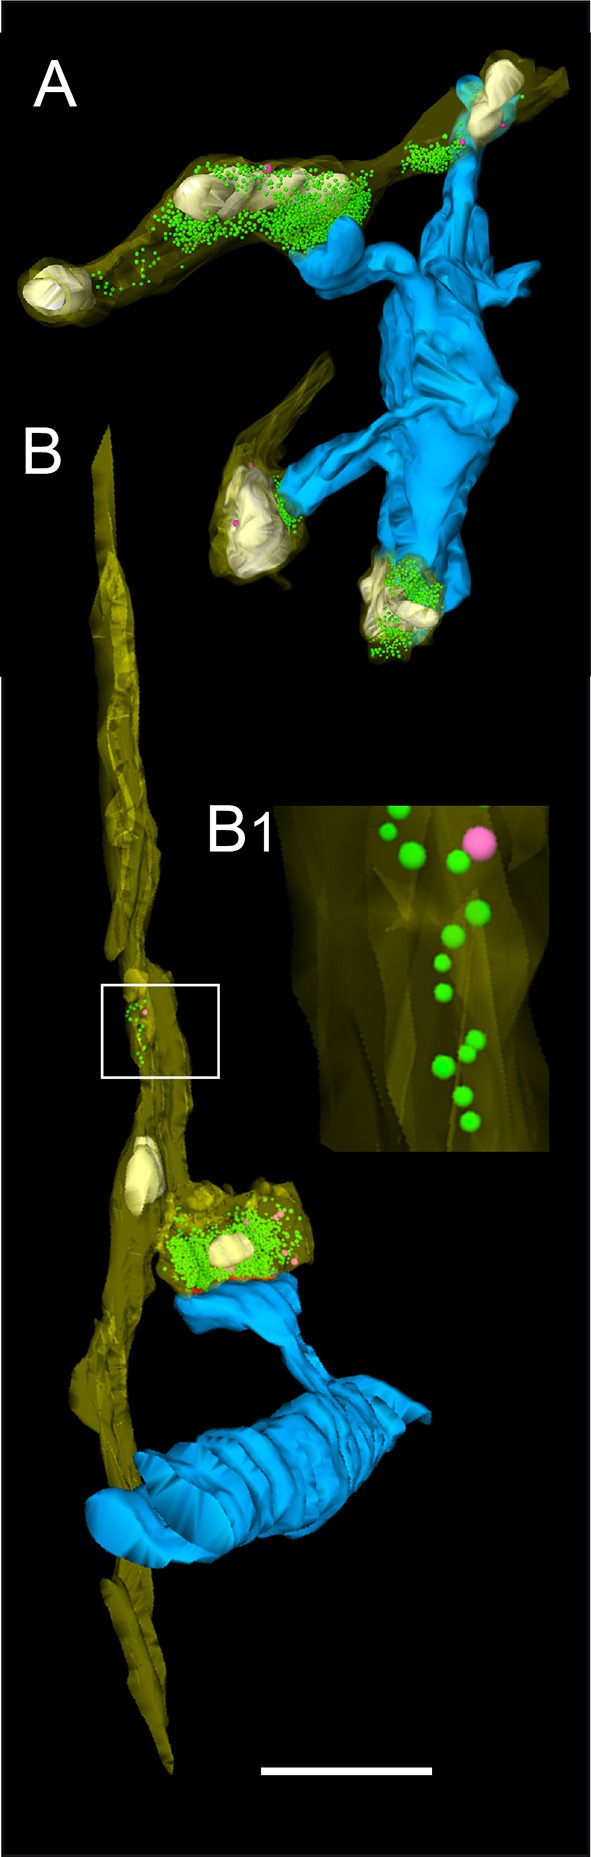
3D-volume reconstruction of synaptic boutons terminating on basal dendrites of L5B thick-tufted pyramidal neurons. (A) Quantitative 3D-reconstruction of four synaptic boutons (transparent gold) terminating on three different dendritic spines and a shaft of the same basal dendritic segment (blue). The outline of the bouton was made transparent to visualize the distribution of mitochondria (white), the total pools of synaptic vesicles (green dots) and that of dense-core vesicles (magenta). (B)
En passant axon (transparent gold) that could be followed over long-distance in consecutive electron micrographs establishing an axo-spinous synaptic contact on a postsynaptic dendritic segment (blue). Note the association of mitochondria (white) with the pool of synaptic vesicles (green dots). The framed area shows the presence of synaptic and a dense-core vesicle within the en passant axon at higher magnification (B1). Scale bar in (A,B) 1 μm.